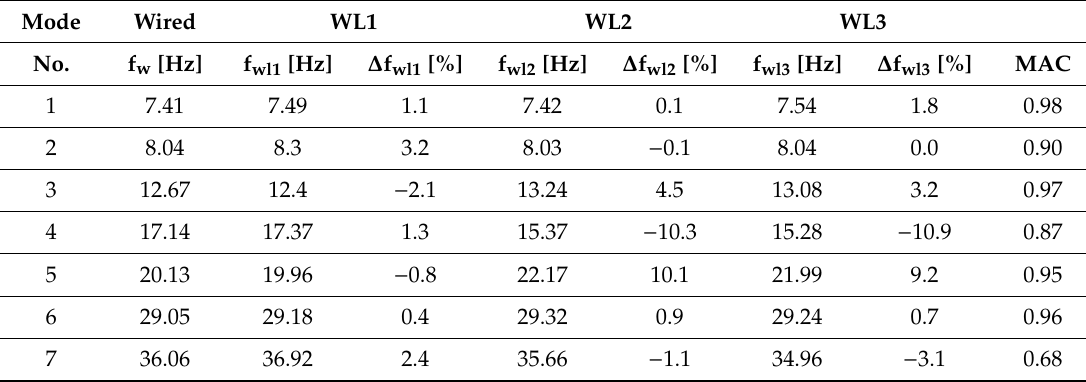
Table 1. Experimental modes as identified from the measurements.